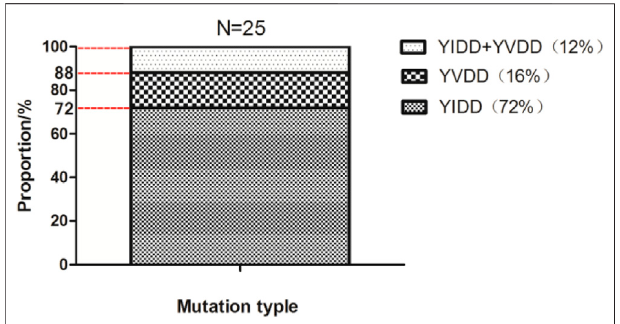
FIGURE 1 | The distribution proportion of YMDD mutations after LAM therapy in CHB